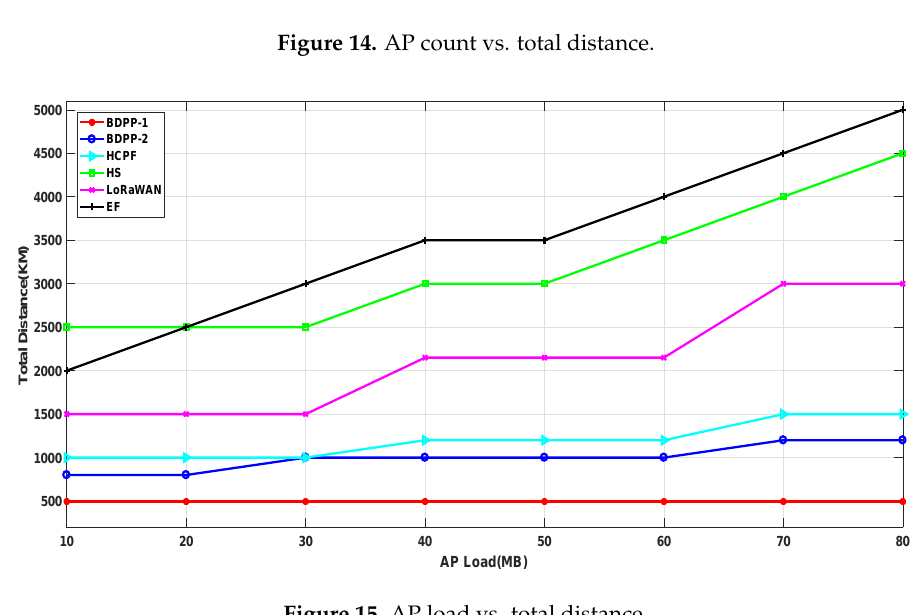
Figure 15. AP load vs. total distance.